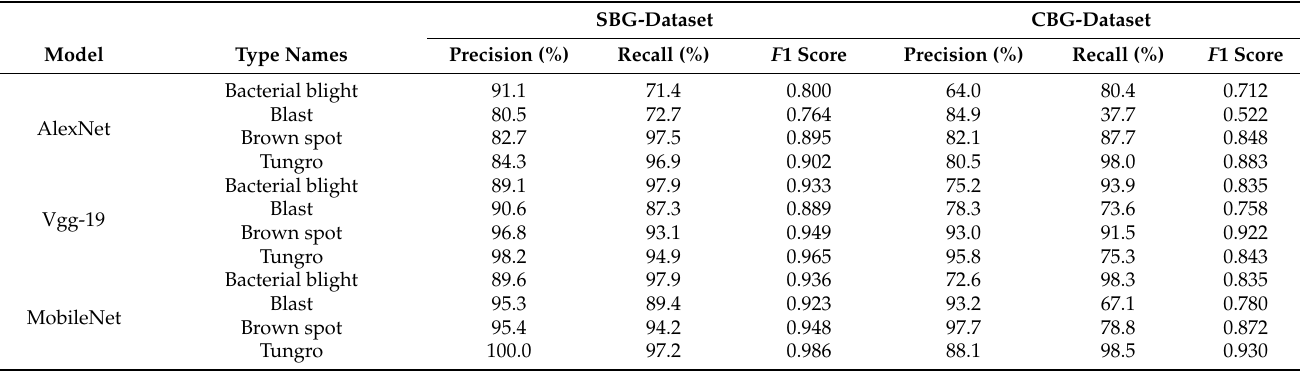
Figure 12. Comparison of accuracy rates of different models for each disease type. Table 8. Comparison of multiple evaluation indicators in different models on each disease type.